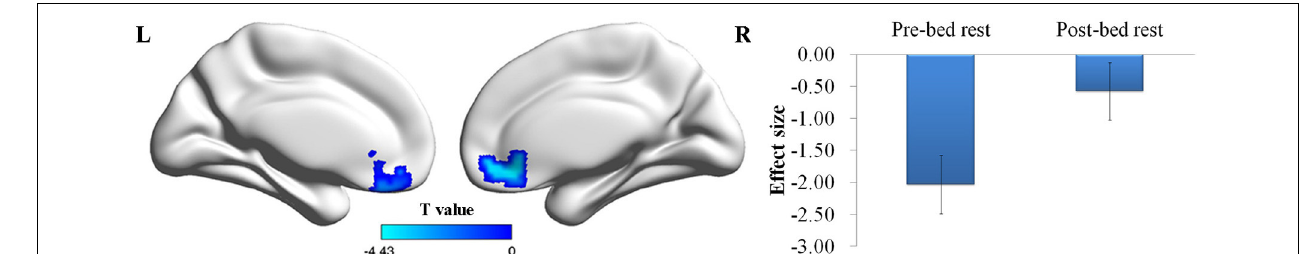
FIGURE 2 | Risk-related brain regions showing the main effect of time. The deactivation of VMPFC decreased after the bed rest. Abbreviations: VMPFC, ventromedial prefrontal cortex. Error bar denotes the standard error.